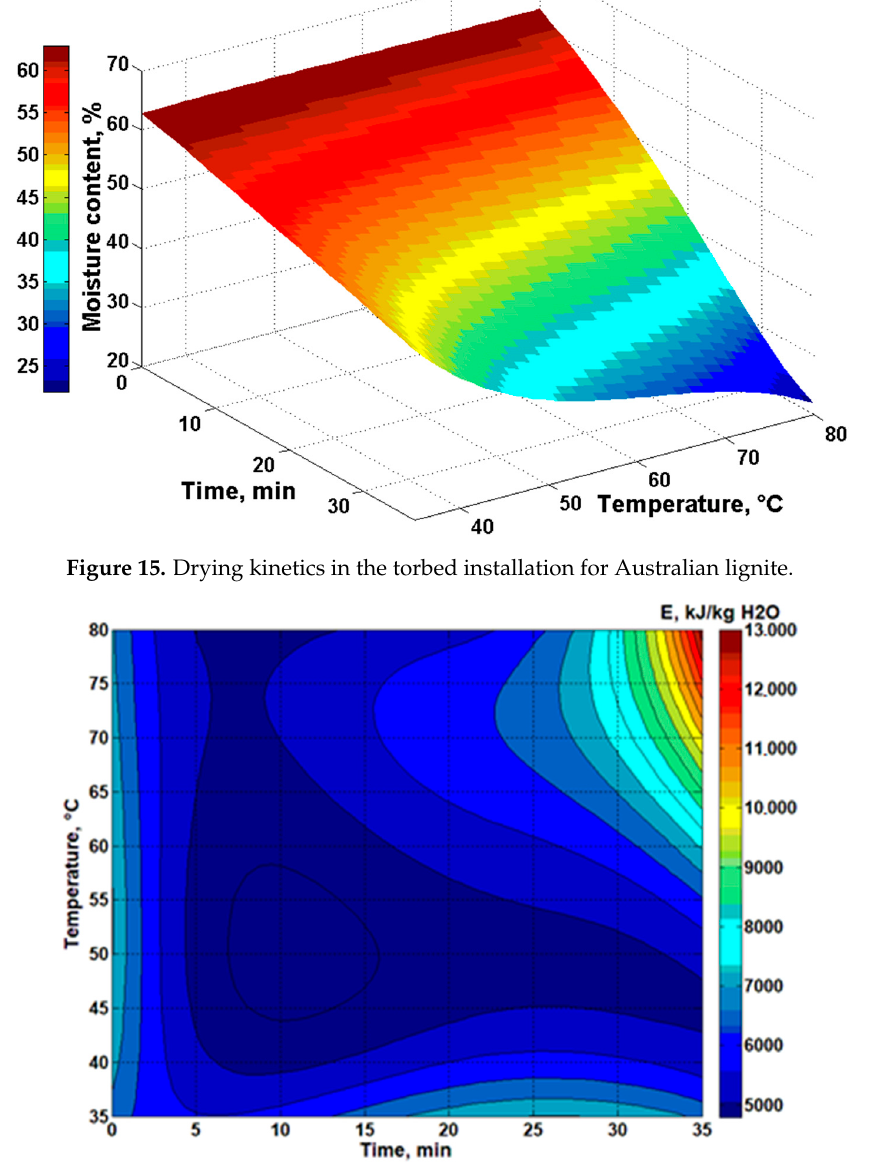
Figure 16. The energy consumption per kg of removed water during drying of the Australian lignite in the torbed installation.